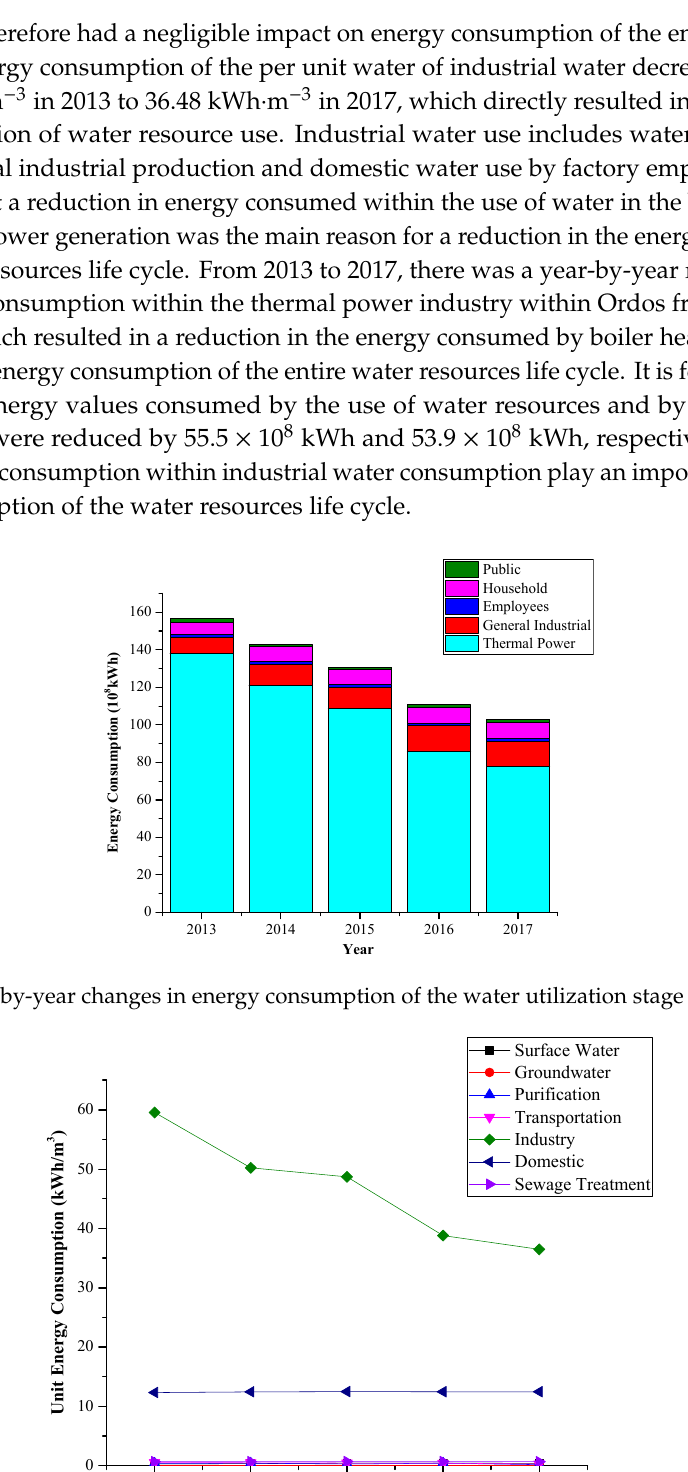
Figure 8. Year-by-year changes in energy consumption of the per unit water of each stage of the water resources life cycle in Ordos, China.